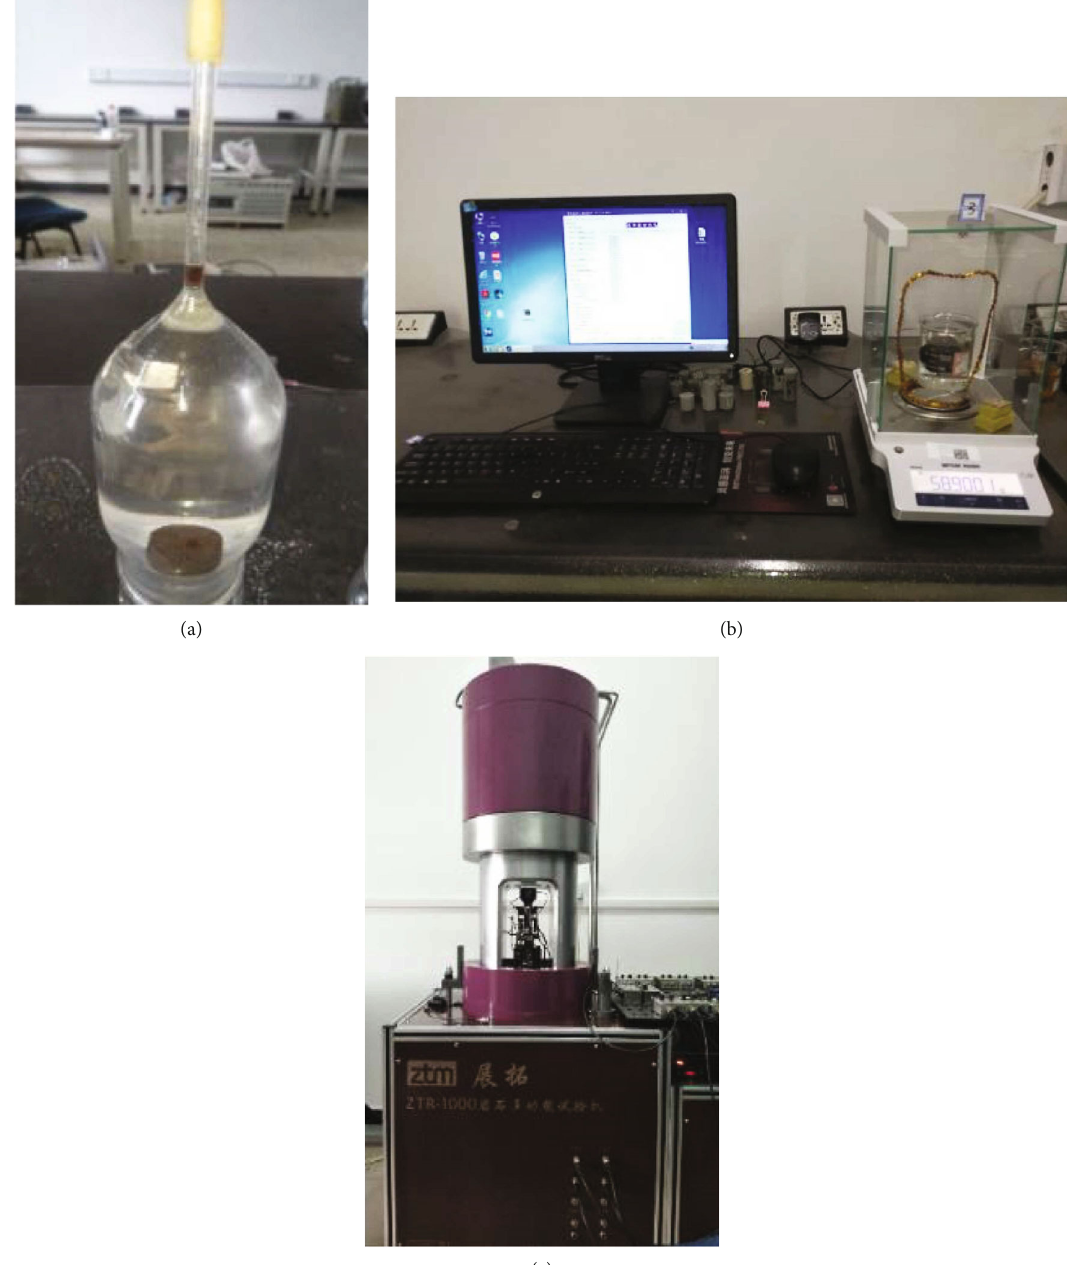
Figure 1: Laboratory equipment: (a) triaxial press, (b) spontaneous imbibition device, and (c) imbibition